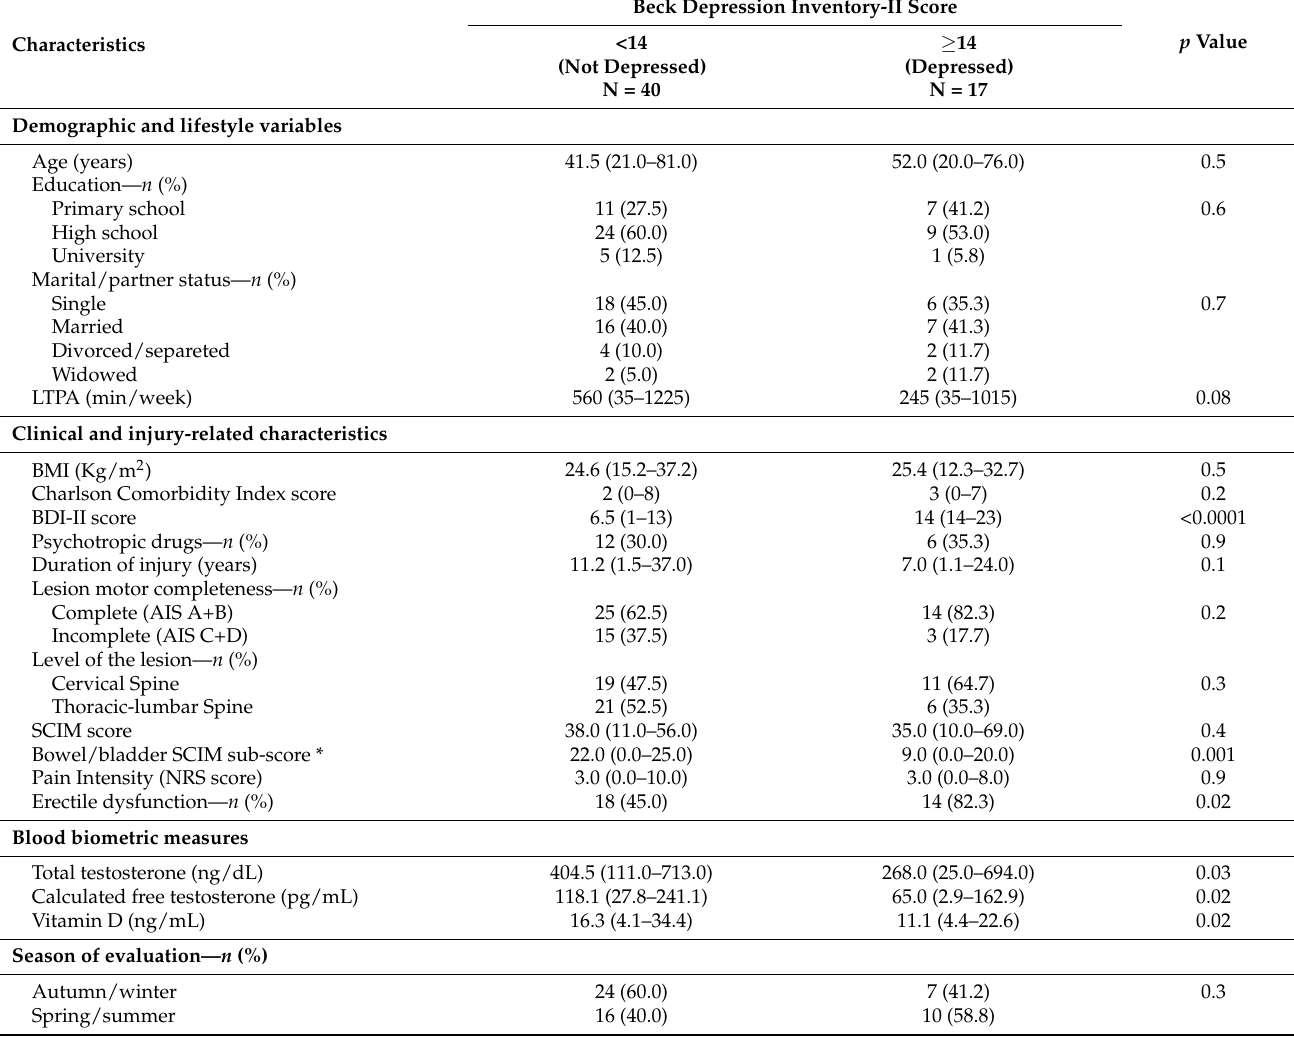
Table 1. Characteristics of the study population categorized by depression status at the Beck Depression Inventory-II.